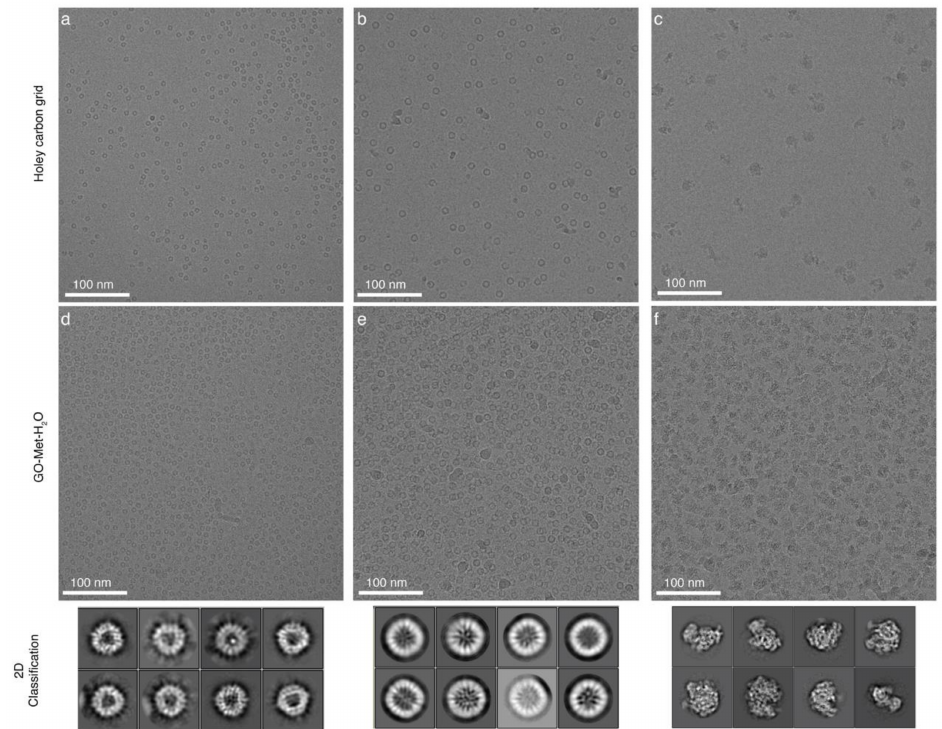
Figure 8. Application of GO methanol-water grid for cryo-EM of biological specimens: ( a – c ) MsDps, Apoferritin and E. coli 70S Ribosome on conventional holey carbon grid. ( d – f ) MsDps, Apoferritin, and E. coli 70S Ribosome on GO-Met-H 2 O grid. Relatively planar and flattened GO-Met-H 2 O coated holey grid is able to adsorb more biological samples than conventional holey carbon grid. Lower panel represents the corresponding reference-free 2D class averages of each protein specimen vitrified on our modified GO grid. 0.1 mg/mL of each sample was applied on the